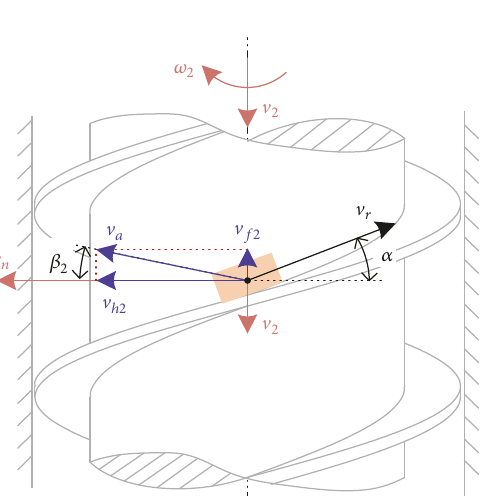
Figure 5: Velocities of cuttings on the screw